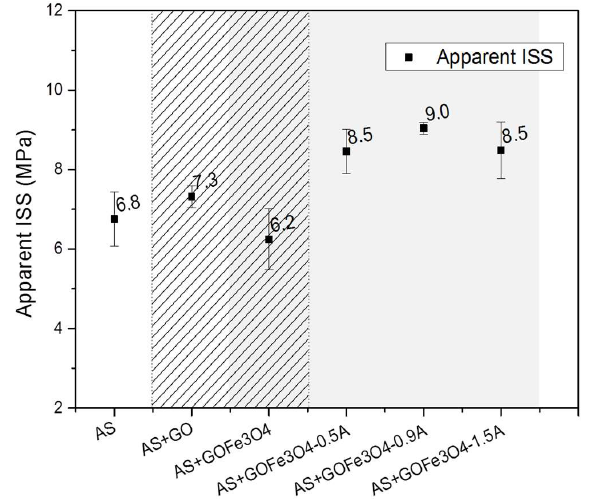
Figure 10. Effect of ferrites and magnetic field on the fiber-matrix interphase with results obtained for the ISS using SBS.